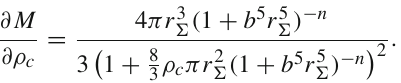
Fig. 2 (Left) In this figure, along x -axis, y -axis and z -axis we have respectively plotted the radius of the star in km unit, the dimensionless quantity n which lies in the range − 200 ≤ n ≤ 200 and the radial pressure p r in MeVfm − 3 unit. (Middle) along x -axis, y -axis and z -axis we have respectively plotted the radius of the star in km unit, the dimen- sionless quantity n which lies in the range − 200 ≤ n ≤ 200 and the